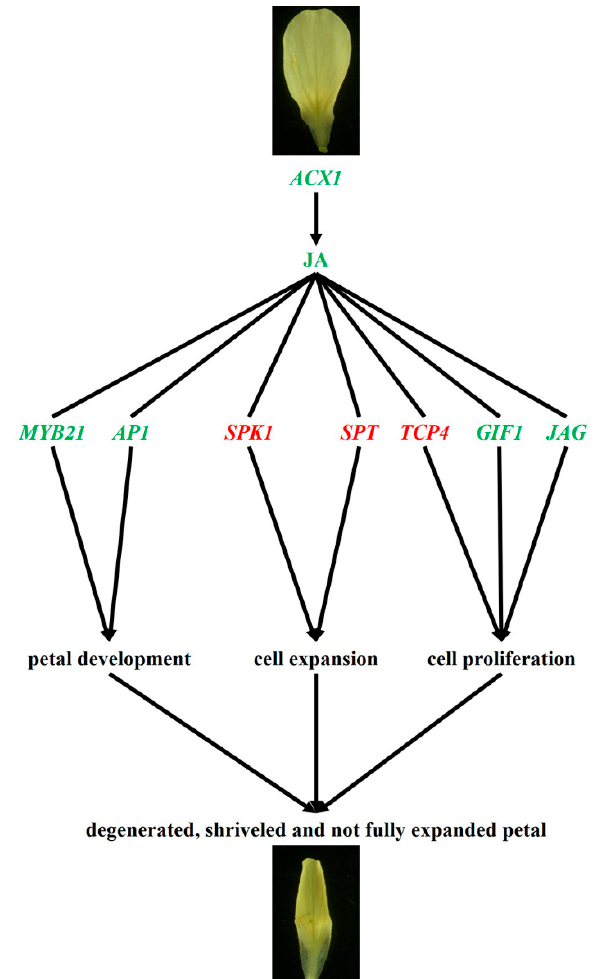
Figure 6. Proposed JA regulatory pathways that contribute to petal development in pdm plants. Note: Genes indicated by red text are up-regulated and those indicated by green are down-regulated.